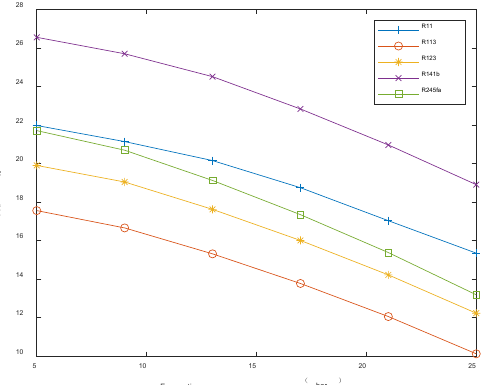
Figure 10. Effect of the evaporation pressure of different organic working fluids on investment profit rate PRI.